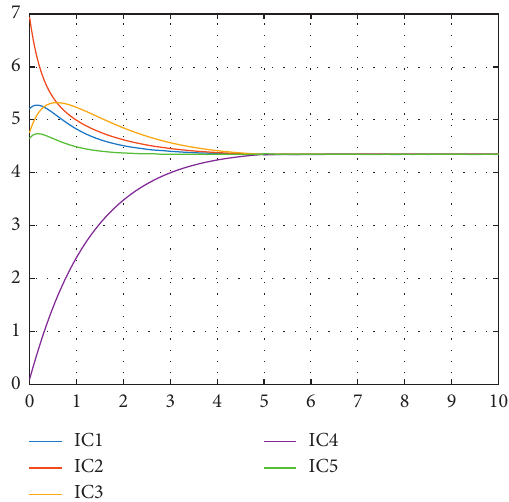
Figure 8: The incremental cost of generator y eration constraints. i with power gen-